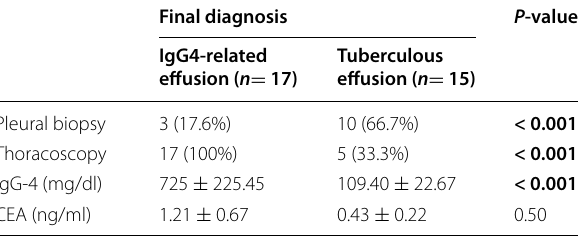
Table 8 The procedures and serum levels of IgG‑4 and CEA